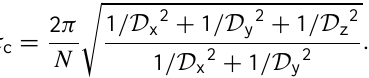
Fig. 17. Horizontal slices of the vertical flux of zonal momentum for an impulsive vertical body force and its image using the FL solutions Fourier-transformed to real space. For this forcing, D = 20km, D z = 10km, and σ t = 0 . 01min. The left, middle, and right columns show the GW response at z = 50, 70, and 90km, respectively. The upper and lower rows show the solutions at t = 35 and 45min, respectively. The resolution is 1x = 6 .